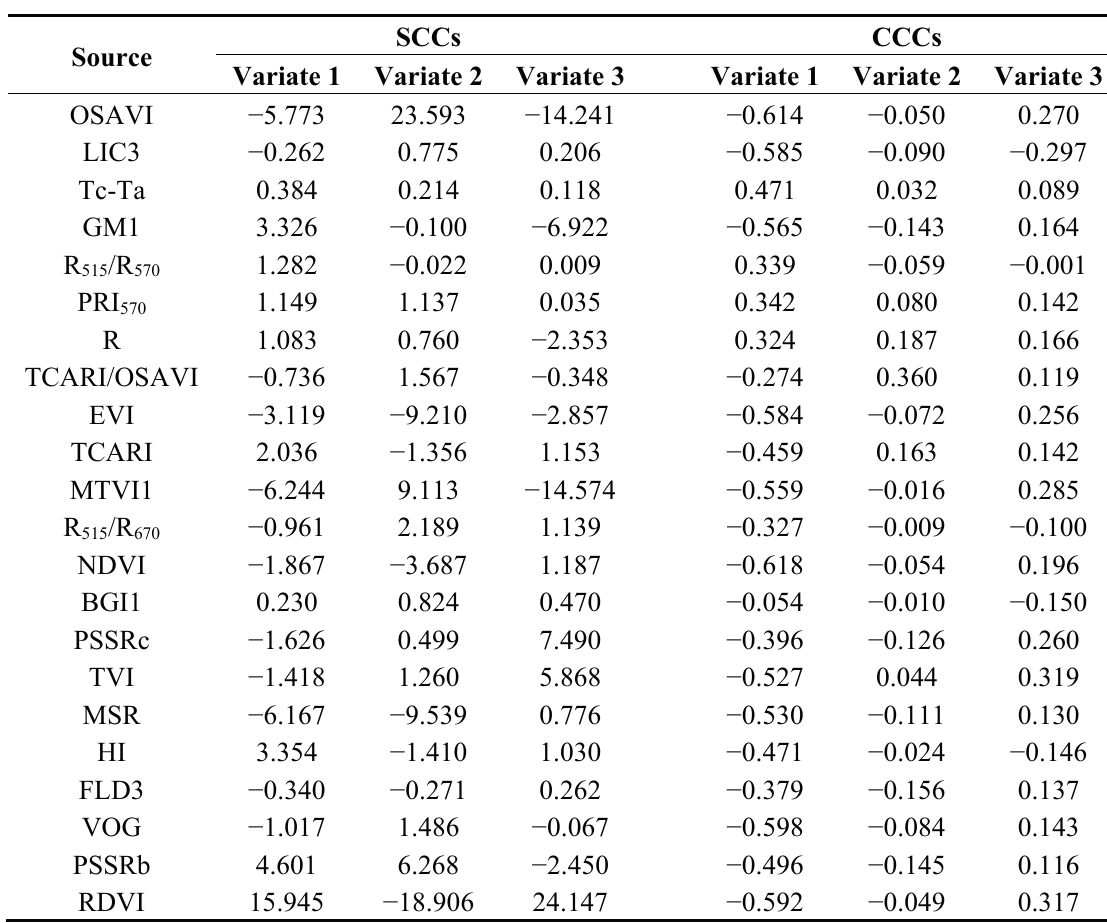
Table 7. Standardized canonical coefficients (SCCs) and correlation coefficients (CCCs) of discriminant canonical functions of canopy normalized canopy temperature (Tc-Ta) and vegetation indices selected by the forward stepwise discriminant analysis that determine Verticillium wilt severity